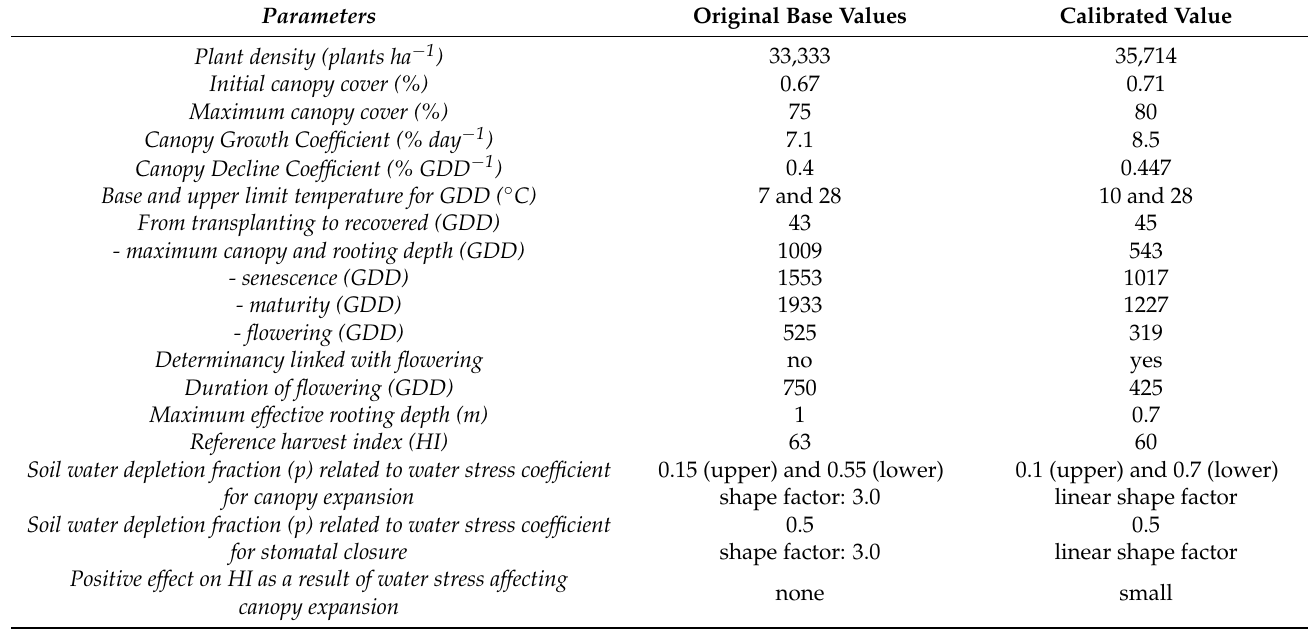
Table 5. The original (default TomatoGDD.CRO) and the calibrated values for the different crop